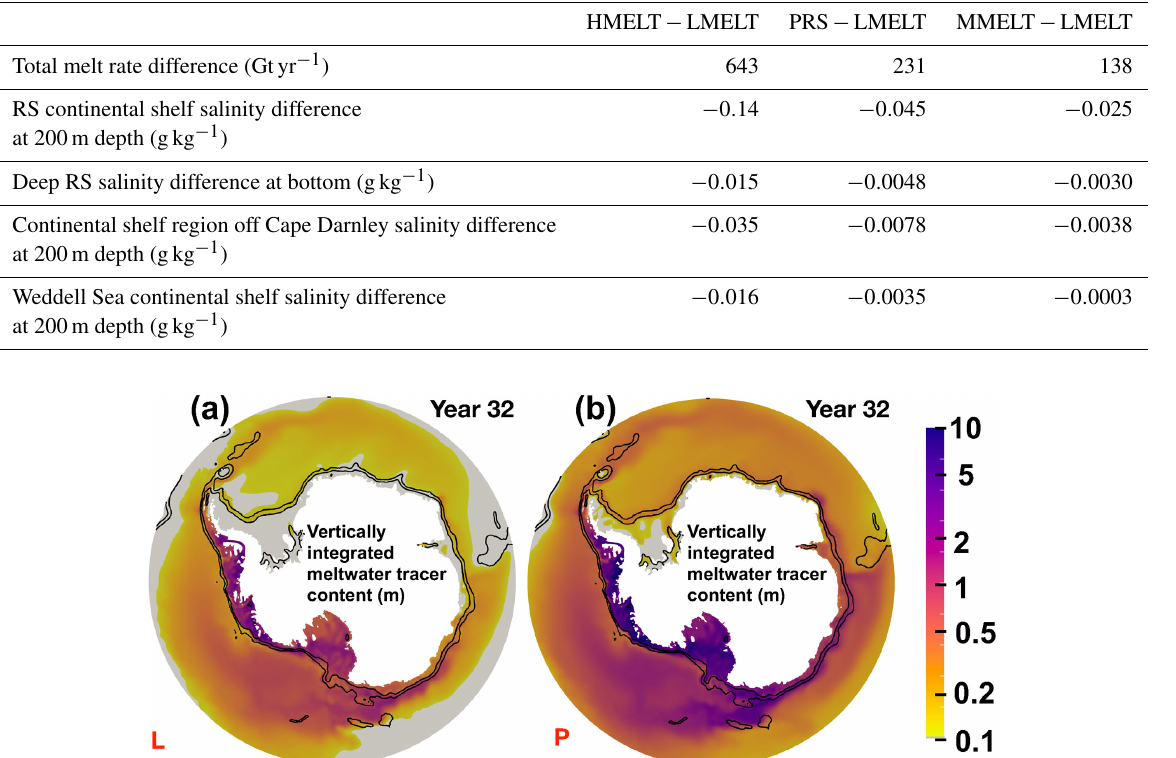
Table 3. Differences in mean Antarctic ice shelf melt rate and spatially averaged salinity for different regions for the last 2 years of model simulations. The LMELT field is subtracted from HMELT, PRS, and MMELT fields to calculate the differences. We calculate spatial averages for the regions indicated in Fig. 1 but using regions shallower than 1000m and regions deeper than 2500m for on-shelf 200m spatially averaged and bottom spatially averaged salinity, respectively.